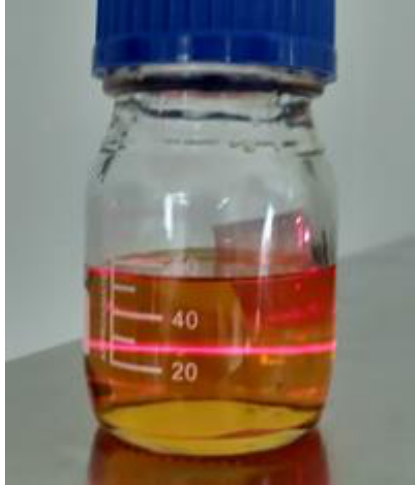
Figure 8. The lead zirconate titanate (PZT) sol.